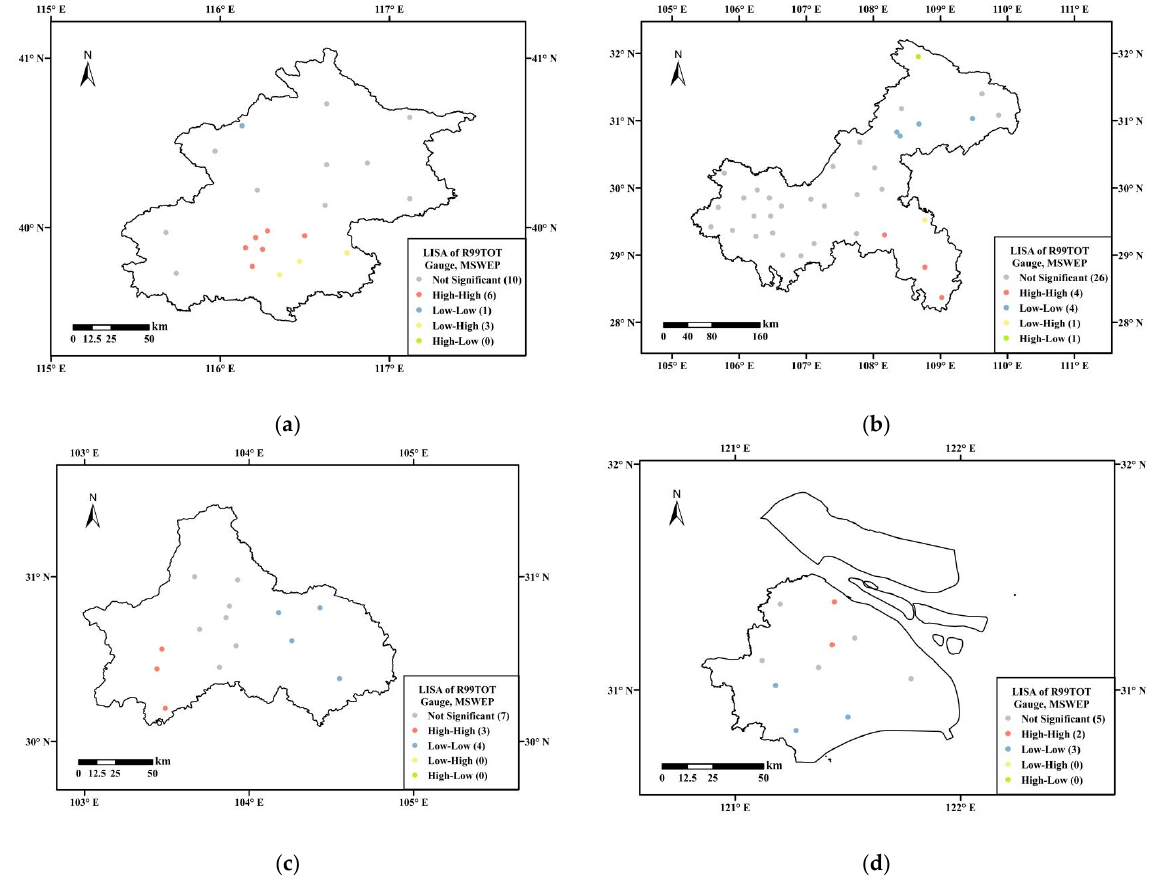
Figure 12. The LISA cluster maps of R99TOT between the gauge observations and SPPs with the highest BMI in four cities: ( a ) Beijing, ( b ) Chongqing, ( c ) Chengdu, and ( d ) Shanghai.